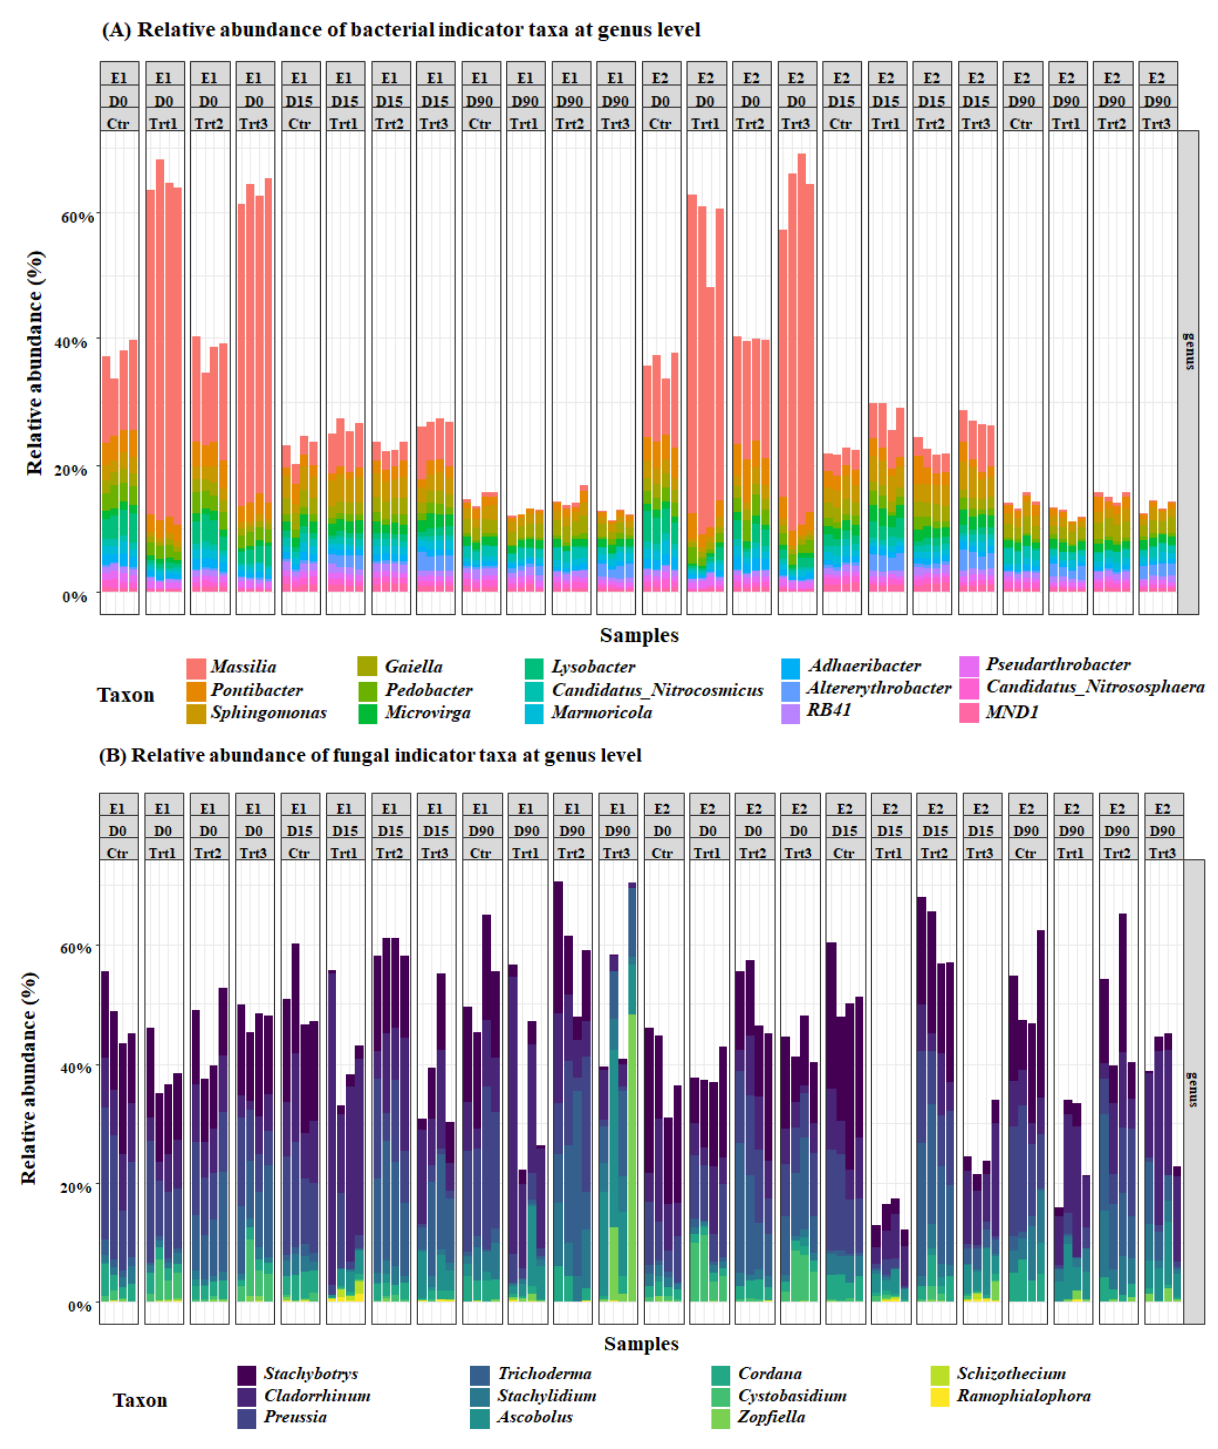
Figure 5. Relative abundance of the most important bacterial ( A ) and fungal ( B ) genera. E1and E2: two experiments with four treatments at different sampling times (D0: after 12 h; D15: after 15 days; D90: after 90 days); Ctr: bulk soil; Trt1: soil with 10 g of beech wood pellets; Trt2: soil with Trichoderma atroviride SC1 conidial suspension at the rate of 5 × 10 3 conidia · g − 1 of soil; Trt3: soil with 10 g of T. atroviride SC1 coated beech pellets (5 × 10 5 conidia · g − 1 of beech wood pellets). Data of each replicate are presented in the histograms.